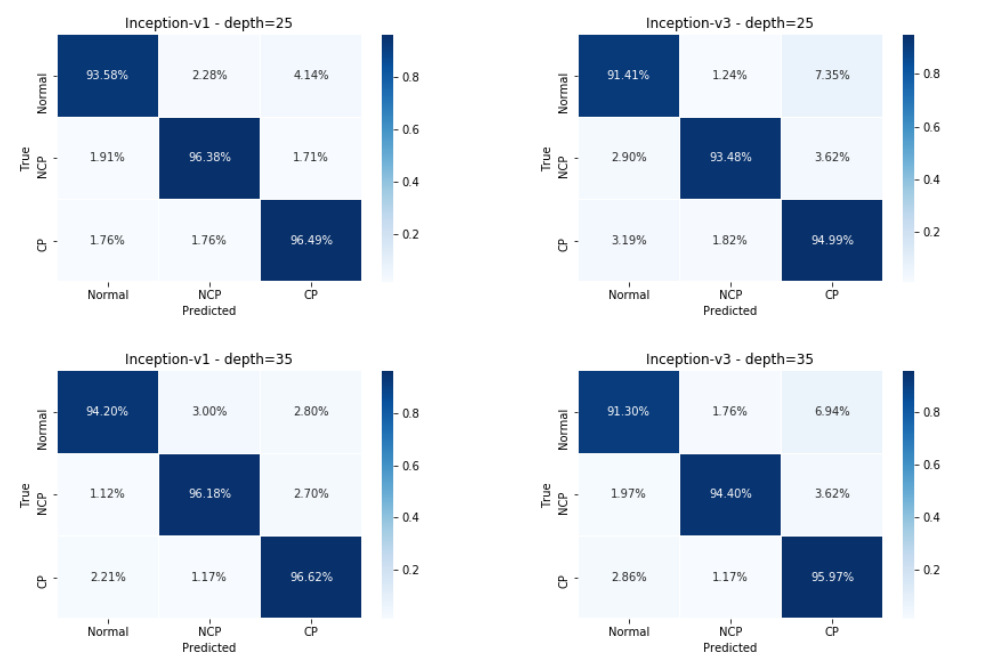
Figure 9. Individual models—The normalized confusion matrices obtained by the models built using the Inception-V1 and Inception-V3 architectures for a CT scan depth of 25 and 35